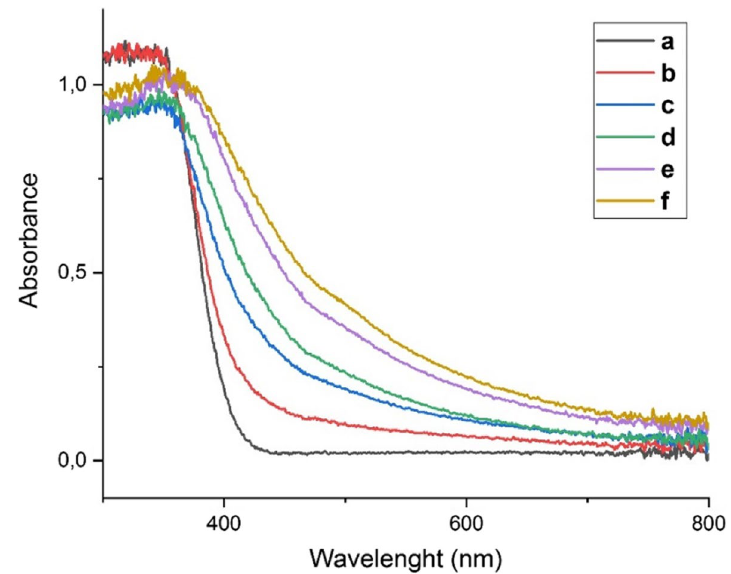
Fig. 2 The SR-UV/Visible spectra of a TiO 2 , b TiO 2 –Fe(1:0.05), c TiO 2 –Fe(1:0.1), d TiO 2 –Fe (1:0.2), e TiO 2 – Fe(1:0.5), and f TiO